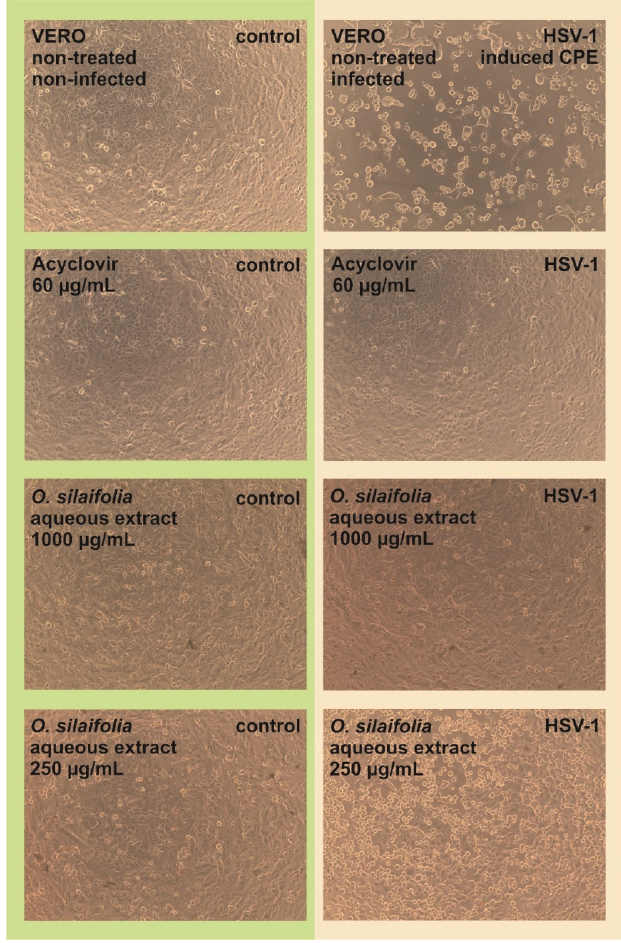
Figure 2. The influence of O. silaifolia aqueous extracts on human herpesvirus-1 CPE in VERO cells.